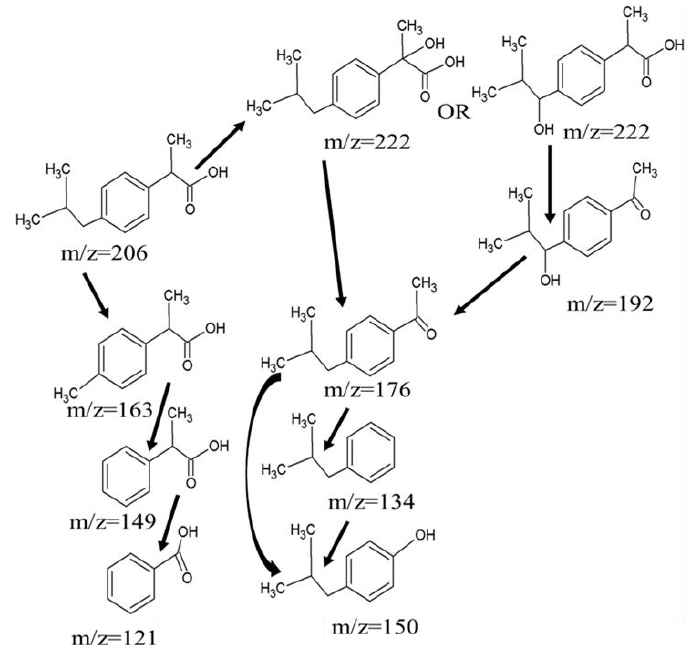
Figure 10. Possible degradation path of IBU in this reaction.